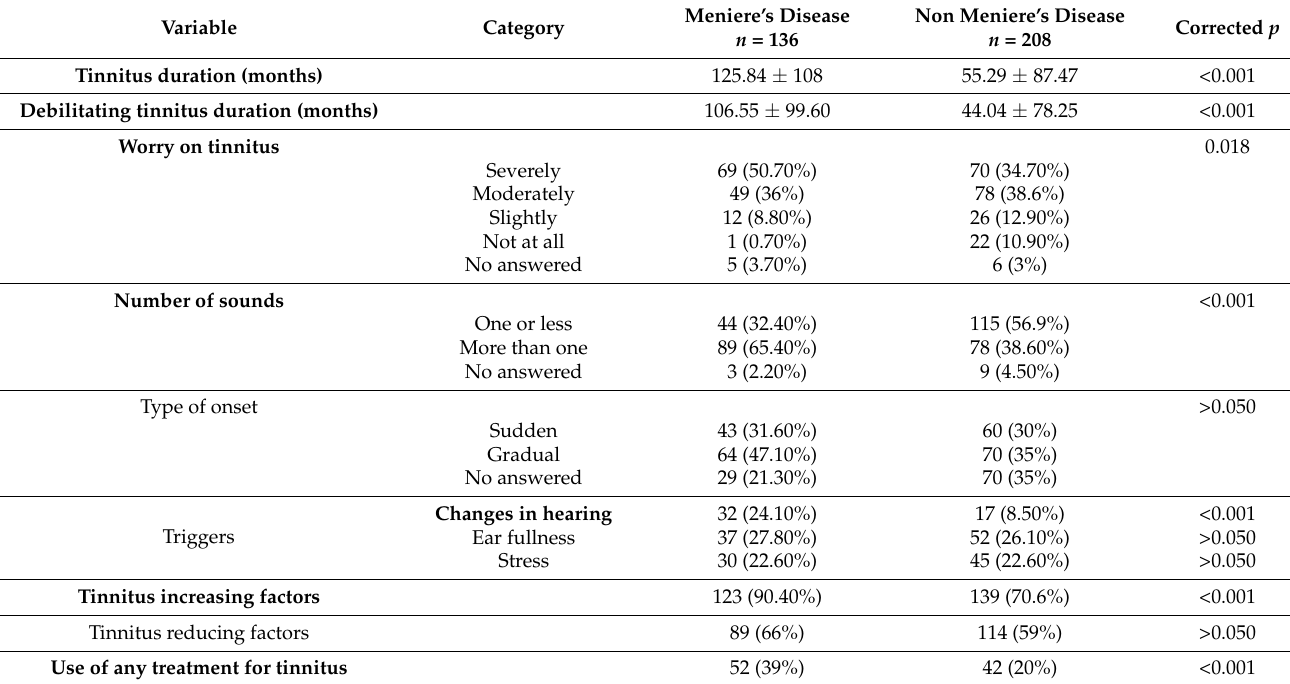
Table 7. Tinnitus characteristics in patients with chronic tinnitus, after stratifying for Meniere’s disease ( n =